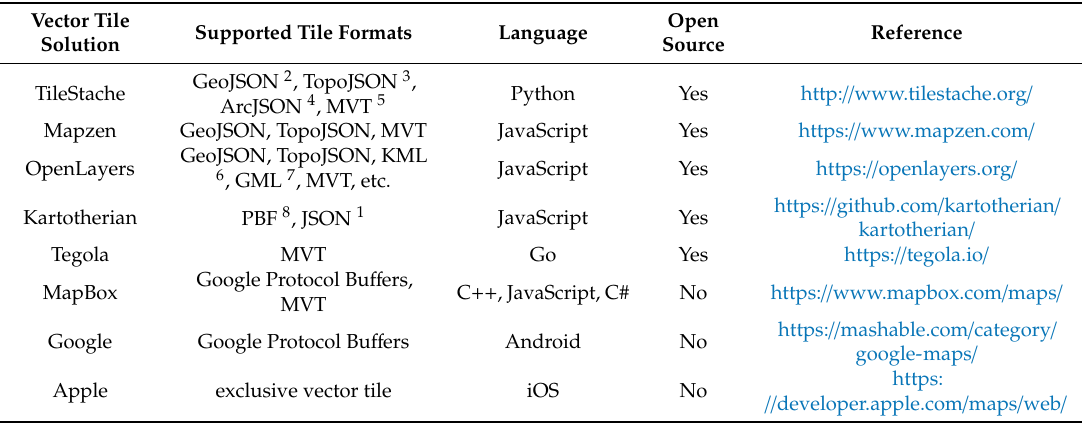
Table 1. Vector tile solutions and the corresponding supported tile